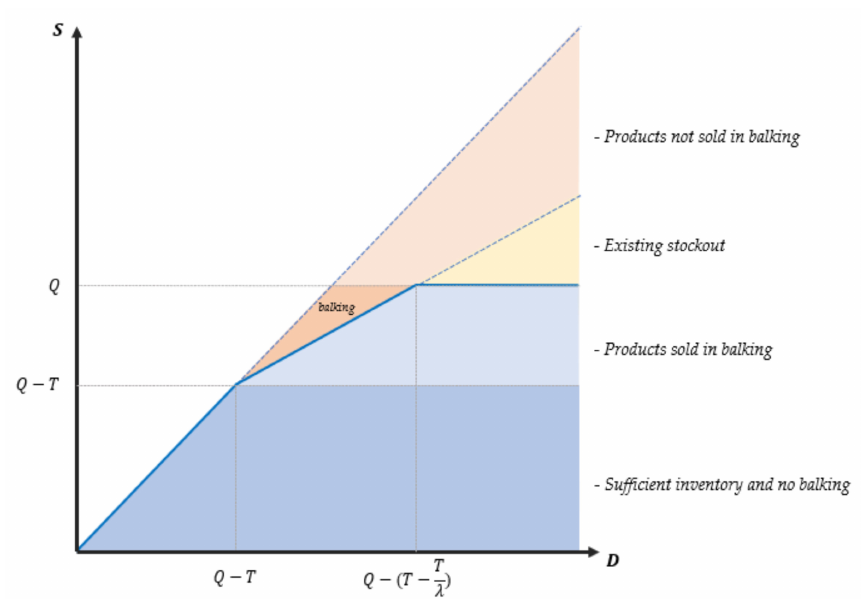
Figure 1. Classification by terms in π F ( Q ) depending on the level of demand and